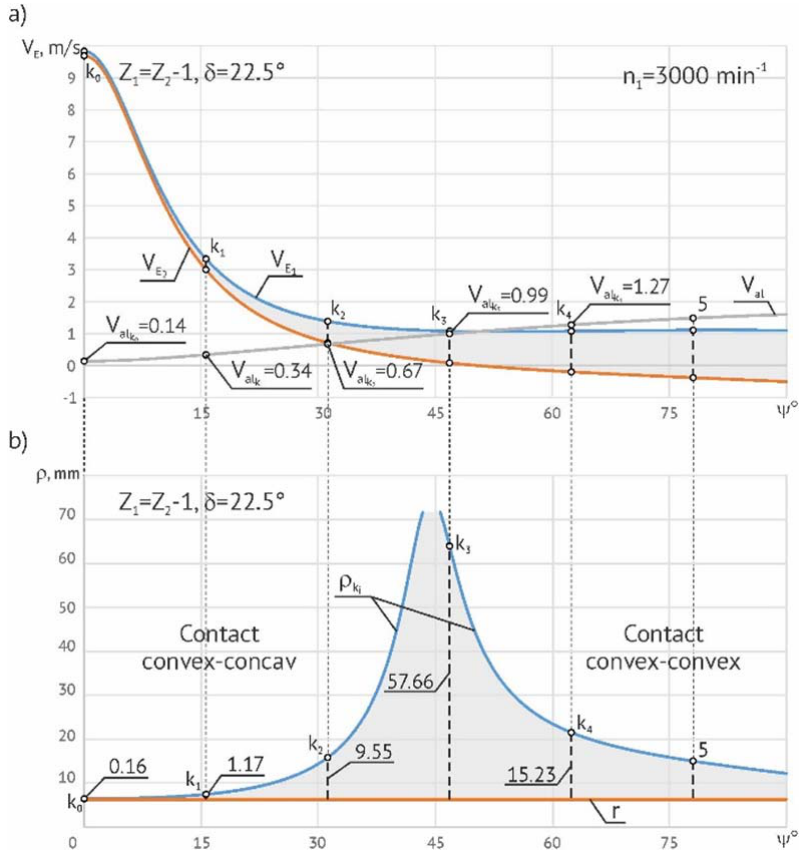
Figure 8 . The linear speeds at the contact point, V , V (a) and the difference in curvature 2 E 3 E radii   ( ) r (b) of the conjugated profiles in the contact k i depending on  for Z 1 =Z 2 - 1 and i k  = 22,5º (Z =24, Z =25,  = 3,5º,  = 22.5º, r= 6.27 mm , R= 75 mm 1 2